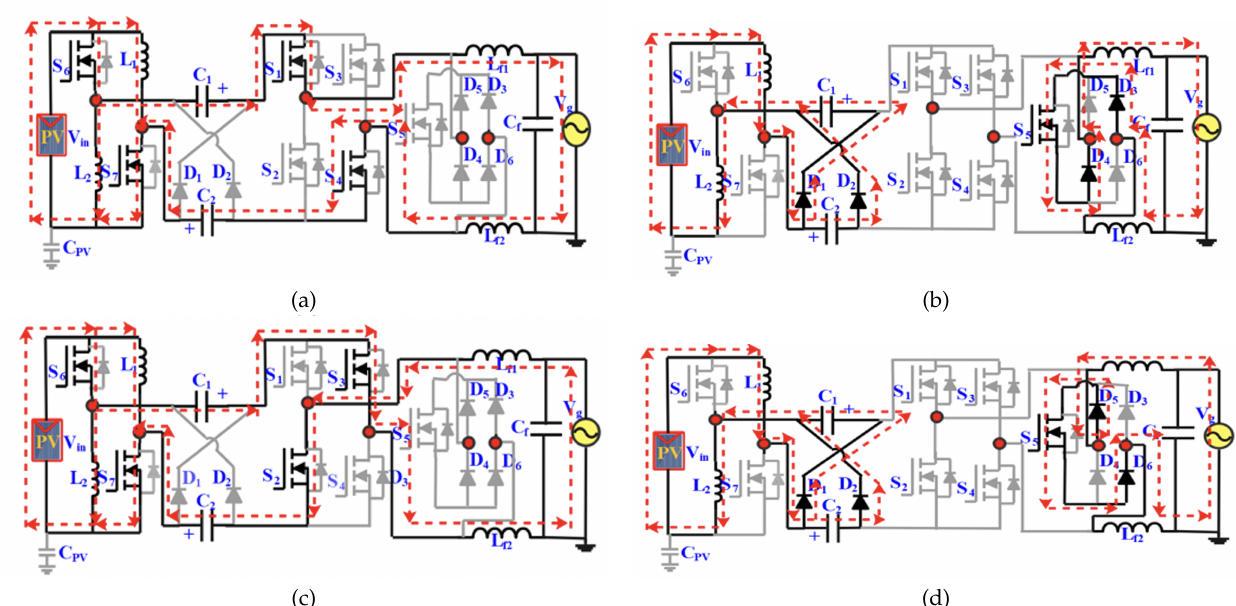
Fig. 3. (a) Positive half cycle active state-I (b) Positive half cycle zero state-II (c) Negative half cycle active state-III